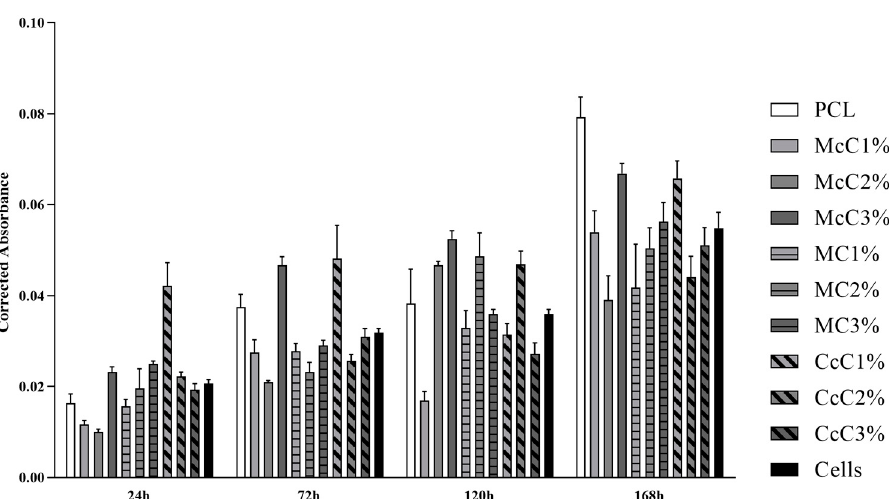
Figure 6. Cytocompatibility between scaffolds and hDPSCs determined at different timepoints using the PrestoBlueTM viability assay. (Mean ± Standard Error of the Mean (SEM)). Statistical differences at each timepoint can be consulted in Figure 7.